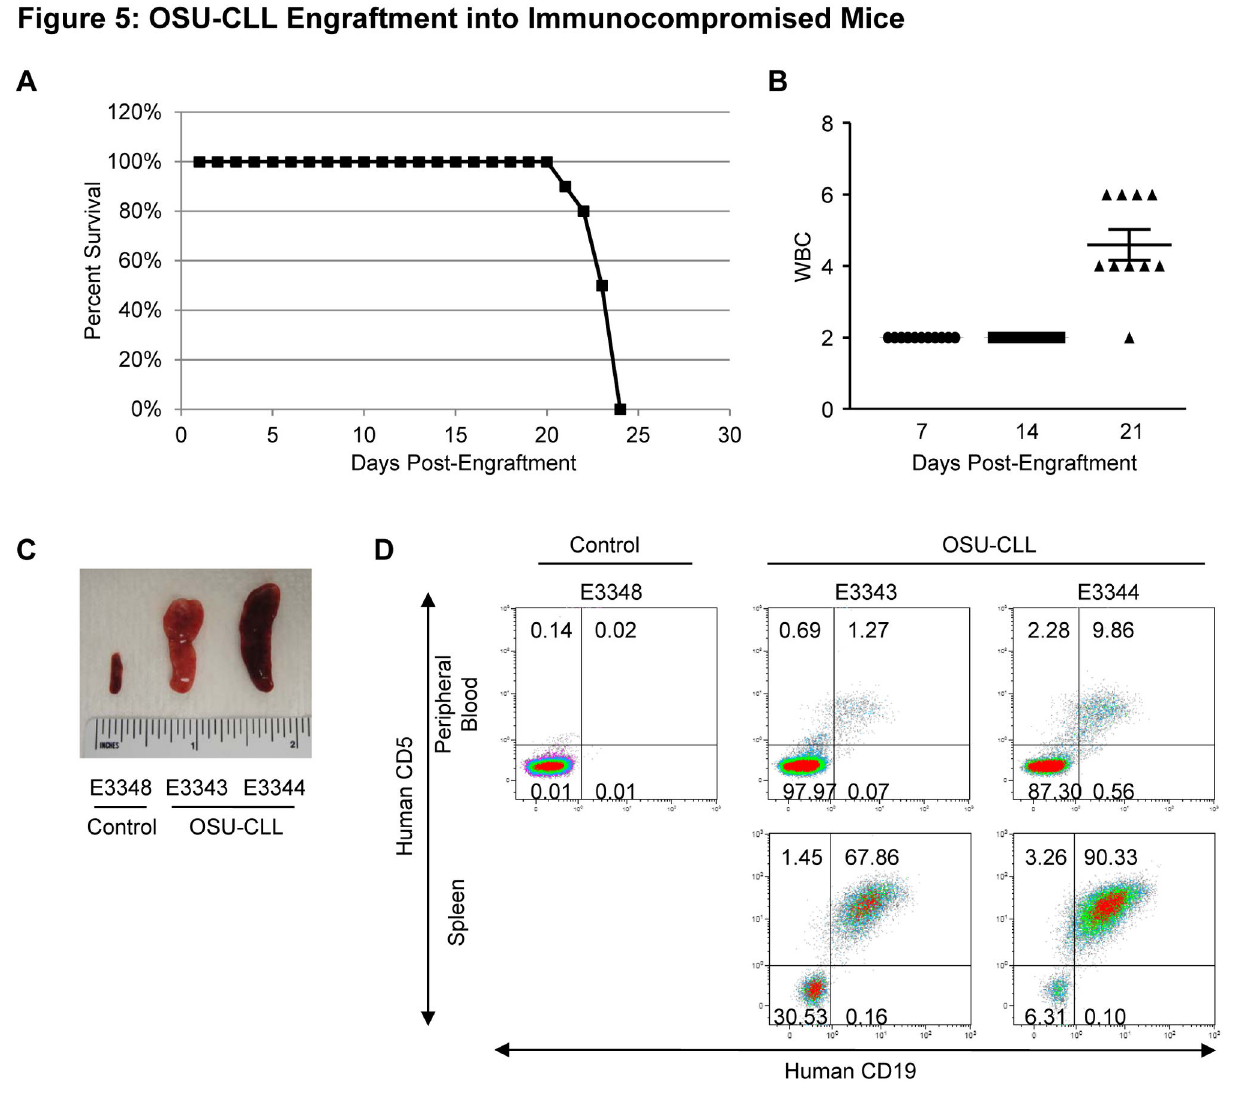
Figure 5. OSU-CLL engrafts into immunodeficient mice. A . Survival curve for NOG mice engrafted intravenously with OSU- CLL (1 x 10 7 cells; N = 10). B . White blood cell count (WBC) at 7, 14 and 21 days post-engraftment, determined by Giemsa staining of peripheral blood smears. C . Spleens collected at the time of sacrifice from a non-engrafted control animal (left) and two animals engrafted with OSU-CLL (middle, right). D . Flow cytometric analysis of surface human CD19 and human CD5 in a non-engrafted control animal and two representative animals engrafted with OSU-CLL. Leukemic cells were detected in both the peripheral blood and spleen cells of the engrafted